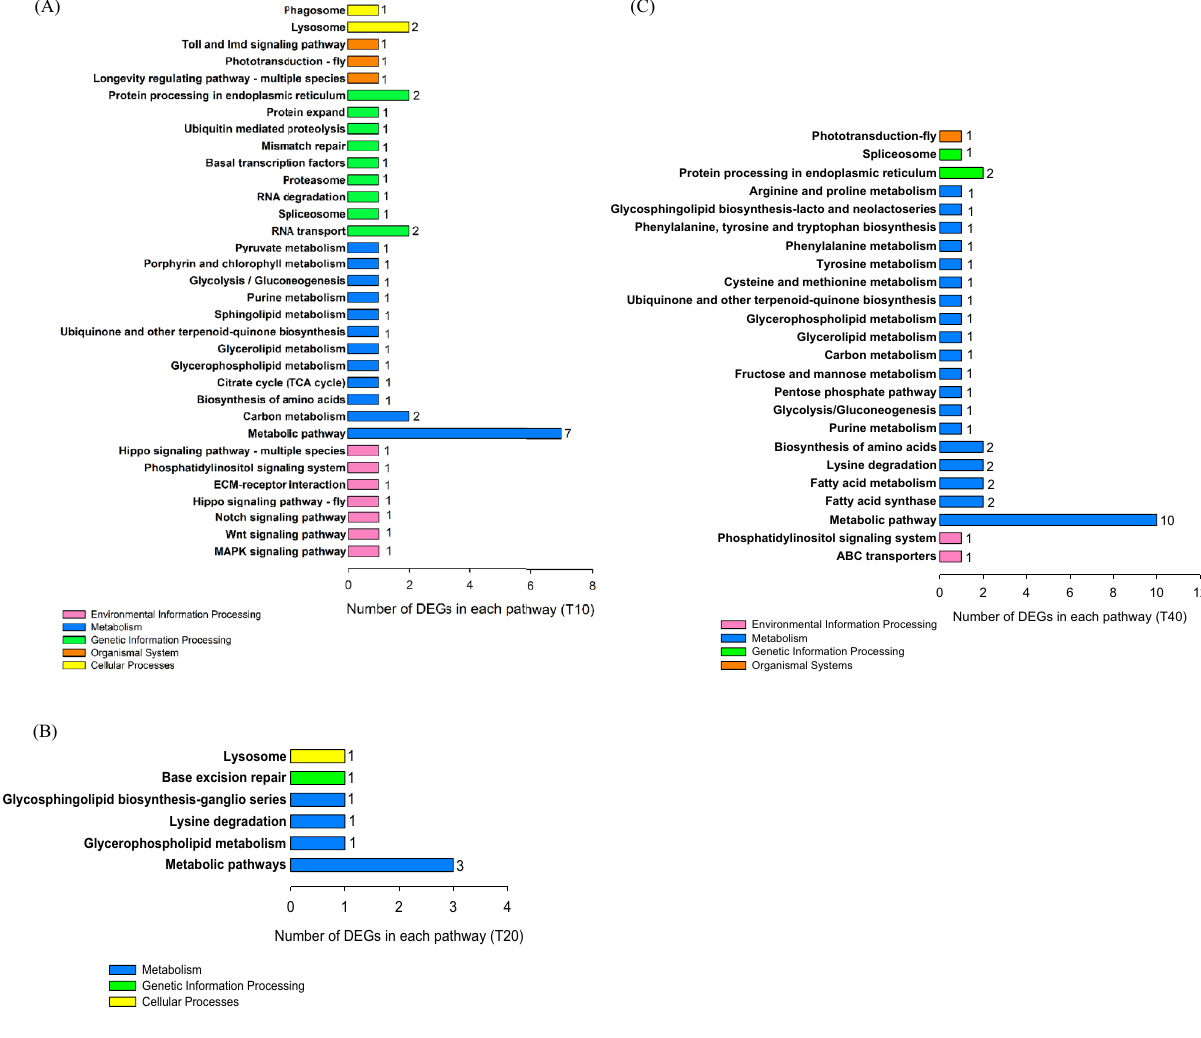
Figure 5. ( A – C ) Analysis of significant KEGG pathway enrichment in the specific Differentially Expressed Genes (DEGs) (p-value < 0.05, log 2 FC ≥ 10) co-regulated by temperature stresses including 10, 20, and 40 °C, respectively. The Y axis indicates the KEGG pathways, and the X axis shows the number of specific DEGs for each treatment group in each pathway that is indicated on the right side of the